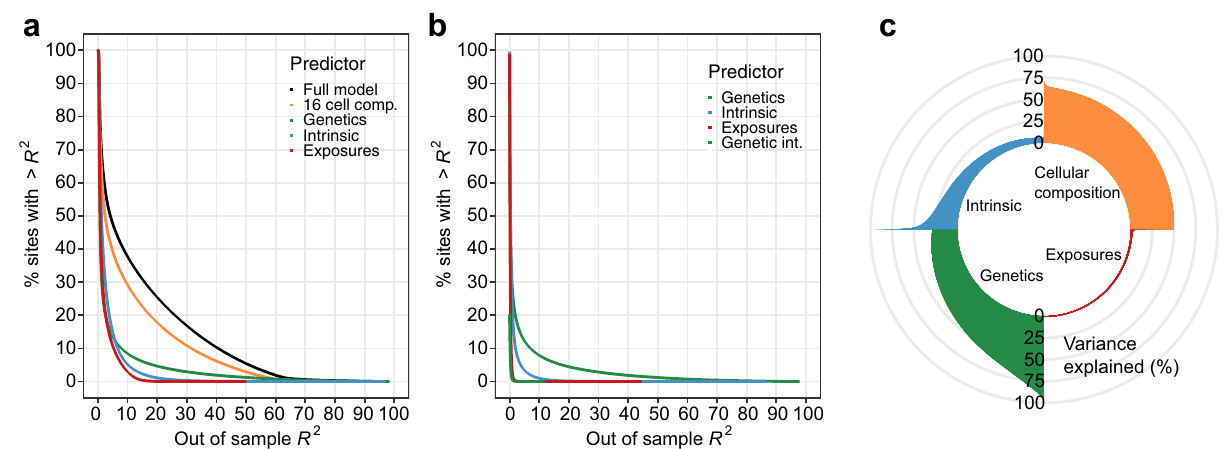
Fig.5|BestpredictorsofthebloodDNAmethylomeofadults.a Complementary cumulativedistributionfunctionoftheout-of-samplevarianceexplainedbythefull model, blood cell composition, genetic factors, intrinsic factors (i.e., age and sex) and environmental exposures (i.e., smoking, CMV infection and CRP levels), for 644,517 CpG sites. b Complementary cumulative distribution function of the out- of-sample variance explained by genetic factors, intrinsic factors, environmental